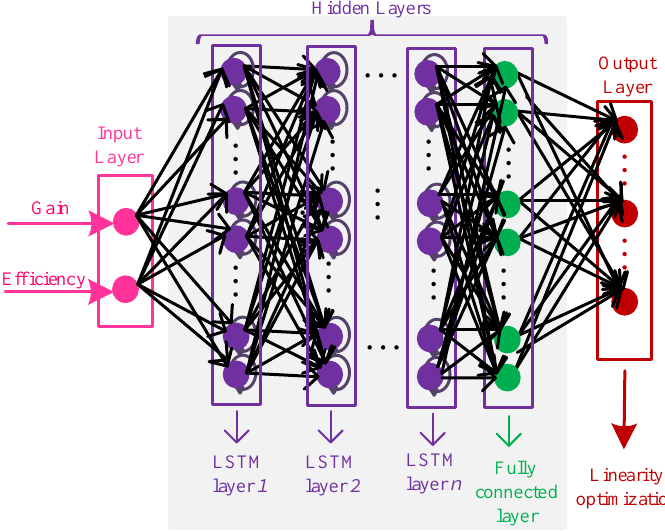
Figure 4. PA modeling through DNN for optimizing linearity connected to the modeled